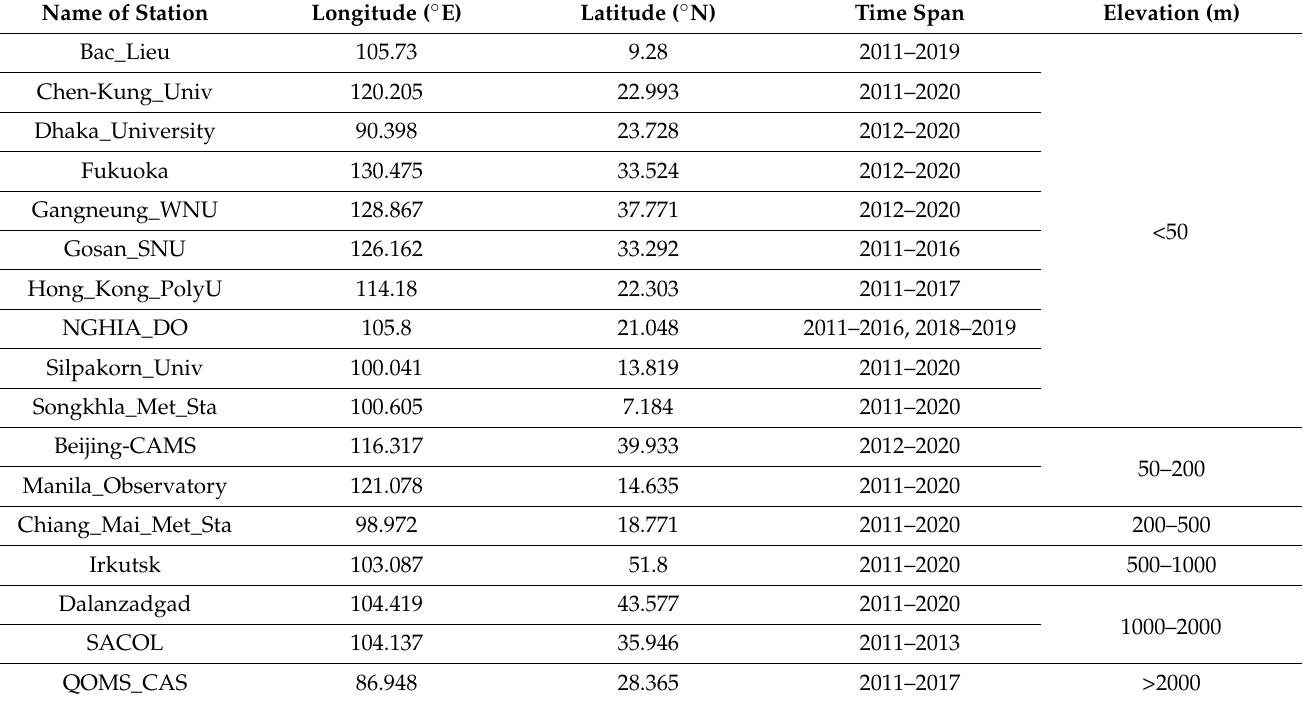
Table 1. Information of AOD ground-based observation